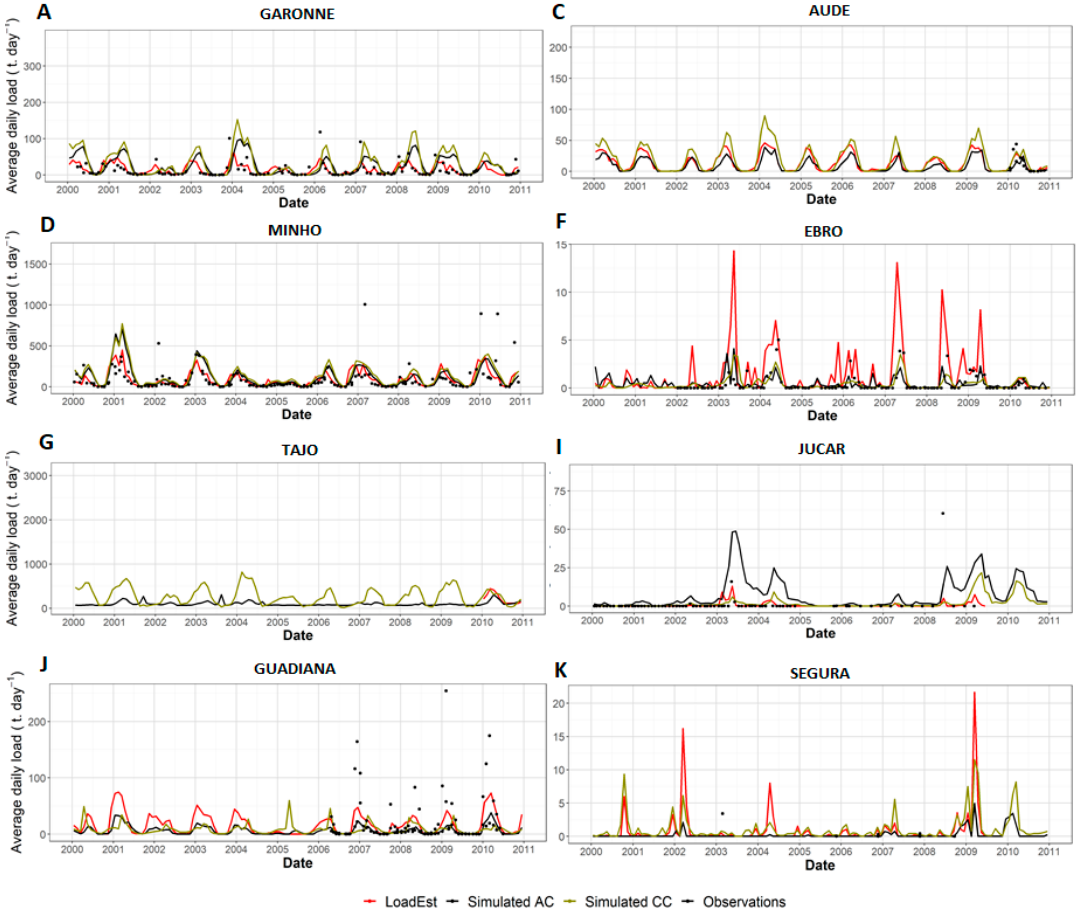
Figure 10. Average variation of daily nitrate loads from 2000 to 2010 (calibration period: 2000–2005: validation period: 2006–2010 simulated at monthly scale) obtained with Load Estimator model (LOADEST) and SWAT versions in the main SUDOE watersheds (AC: additional calibration; CC: conventional calibration). The letters( A – K ) indicate the watershed localization over SUDOE territory (Figure 2).